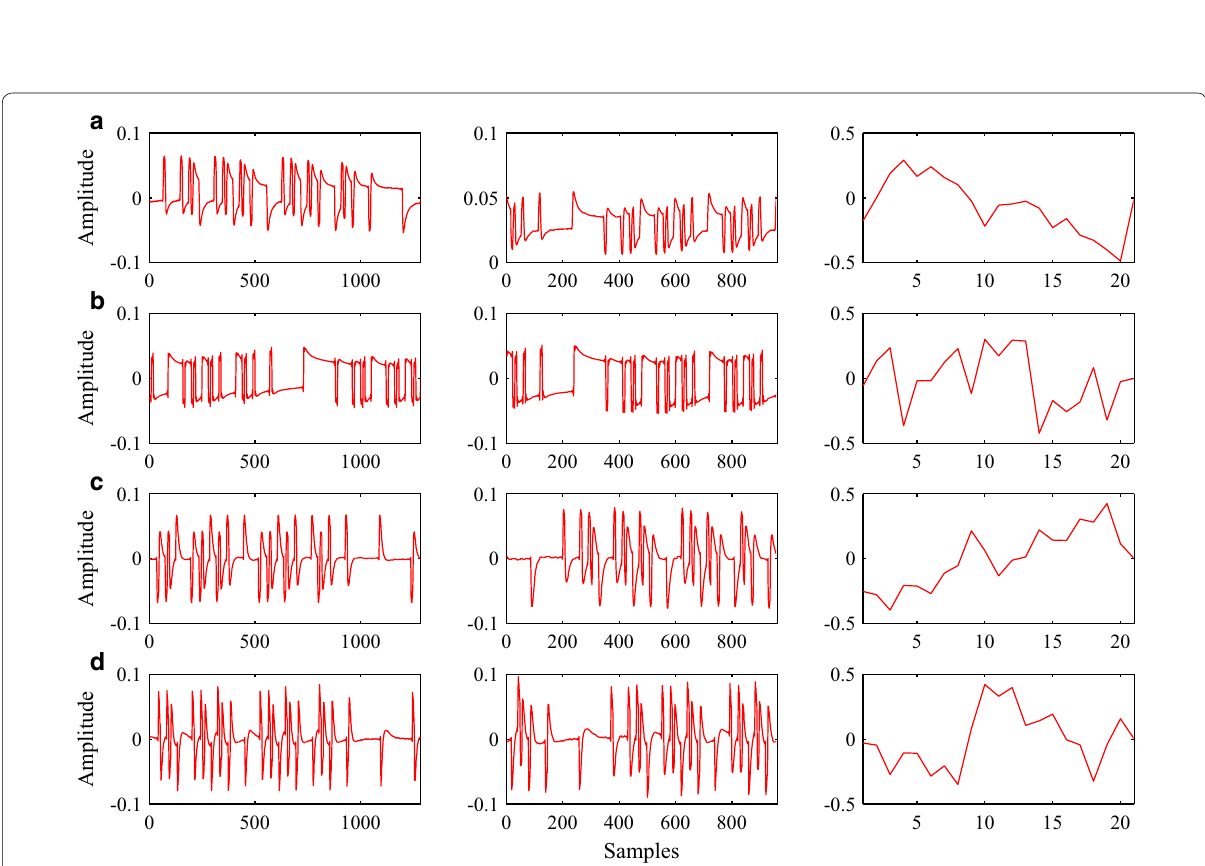
Fig. 7 Feature structures (atoms) learned from Ex ( a ), Ey ( b ), Hx ( c ) and Hy ( d ) components of the MT data set D 1 (a sampling rate of 15 Hz) using